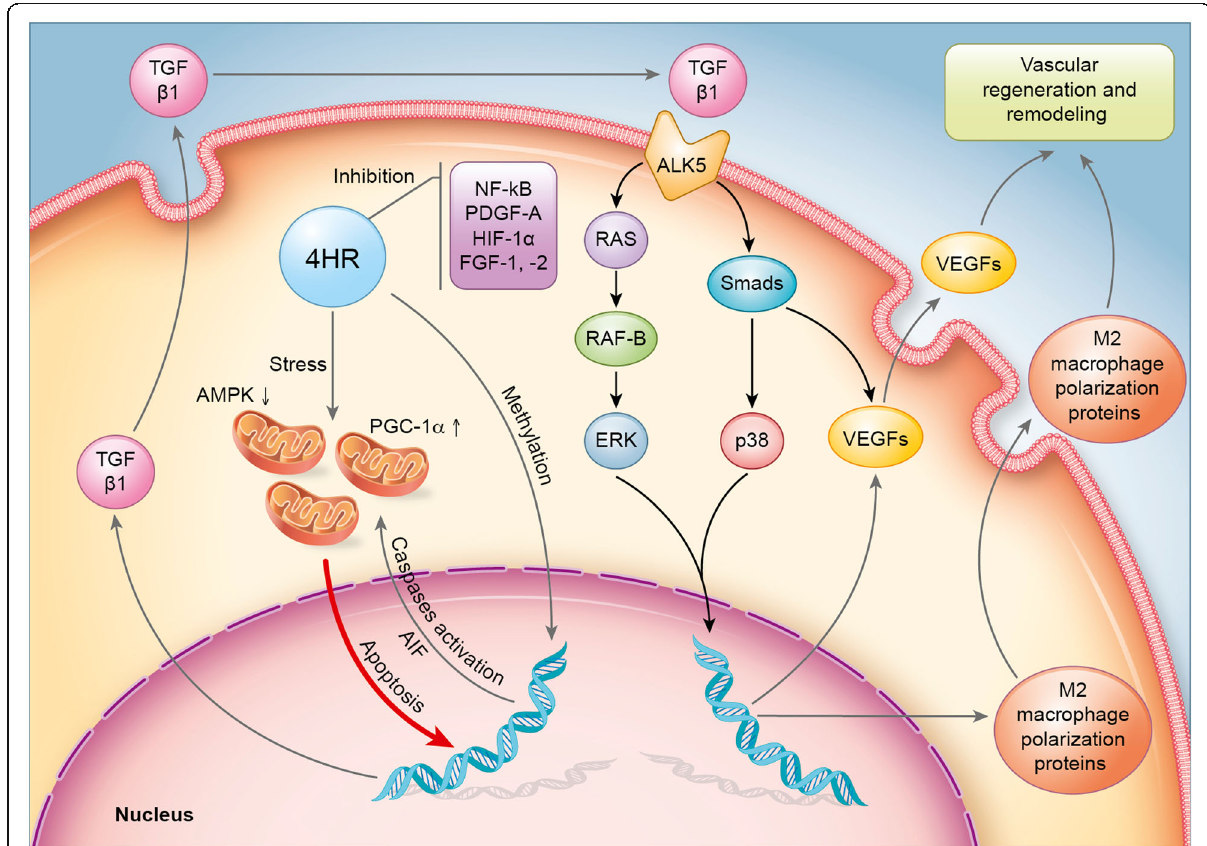
Fig. 5 Schematic drawings for the proposed mechanism. Apoptotic stress on the mitochondria is induced by application of 4HR. This stress induces TGF- β 1 expression, and secreted TGF- β 1 protein will bind to ALK5. Then, the downstream signal is generated by the RAS/Smads pathway. This signal will increase the expression of